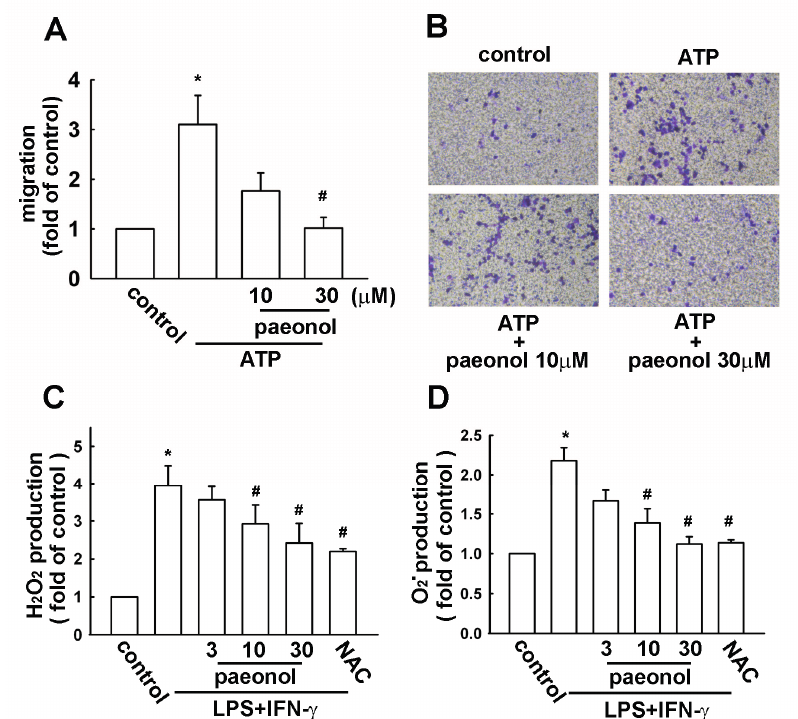
Figure 2. Effects of paeonol on cell migratory activity and ROS production in BV-2 microglia. ( A ) Cells were pretreated with paeonol (10 or 30 μ M) for 30 min followed by stimulation with ATP (300 μ M) for 24 h. In vitro migratory activities were examined using a cell transwell insert system. The results are expressed as means ± SEM of three independent experiments; The migrated cells were visualized by phase-contrast imaging ( B ); ( C , D ) Cells were pretreated with paeonol (3, 10, or 30 μ M) or N -acetylcysteine (NAC) (1 mM) for 30 min followed by stimulation with LPS (10 ng/mL)/IFN- γ (10 ng/mL) for 2 h, the production of reactive oxygen species (ROS) were examined by fl ow cytometry; H 2 O 2 and O 2 − generation were determined using the fl uorescence probes DCFH-DA ( C ) and DHE ( D ), respectively. Results are expressed as the mean ± SEM of four independent experiments. * p <